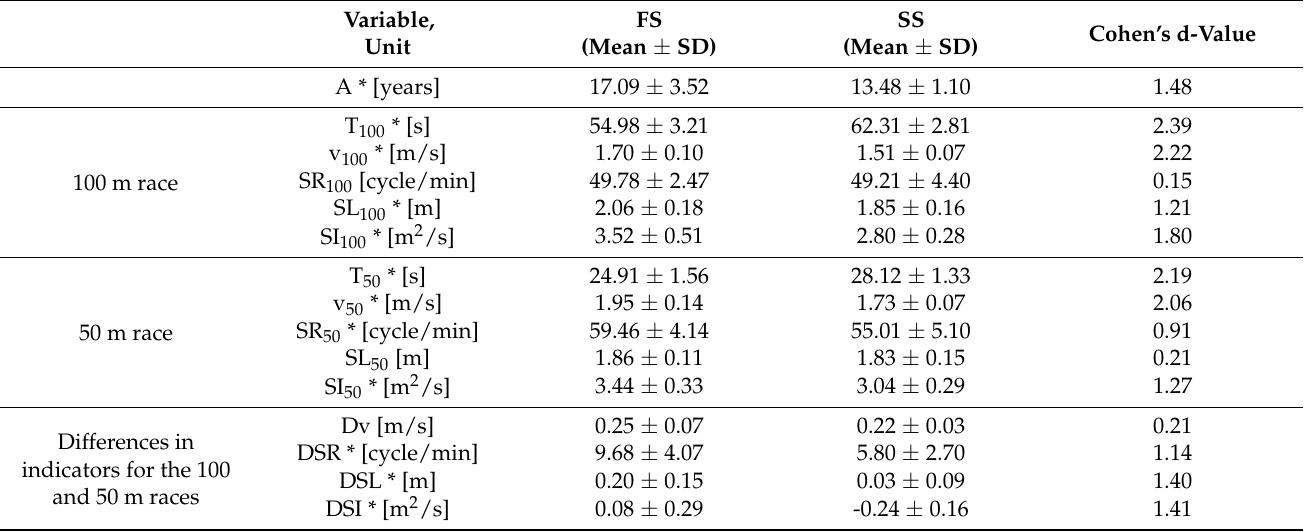
Table 1. Values of kinematic variables describing the 100 and 50 m freestyle races in the FS (faster swimmers) and SS (slower swimmers) groups, taking differences between groups into account.